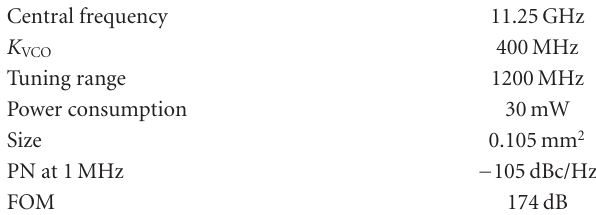
Table 2: Measured VCO characteristics comparison.